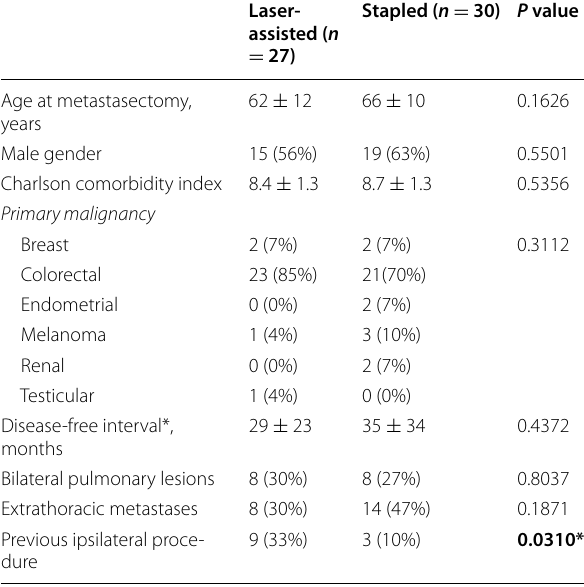
Table 2 Patient and baseline clinical characteristics. *Disease- free interval refers to the time between resection of primary malignancy, and detection of metastatic